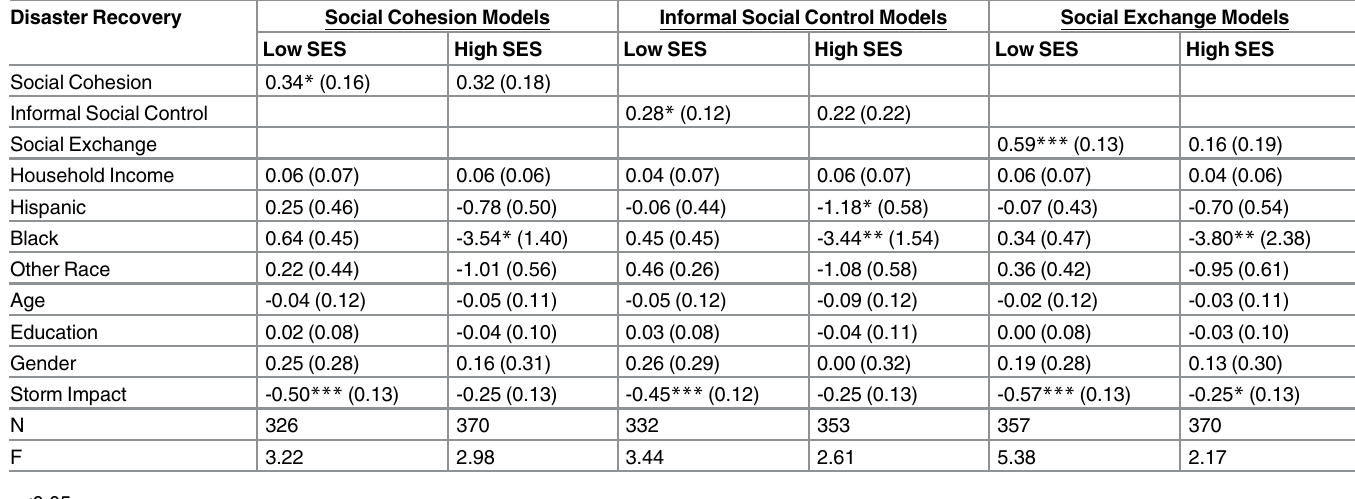
Table 5. Social resources and their associations with beliefs about recovery from future disasters for low and high SES